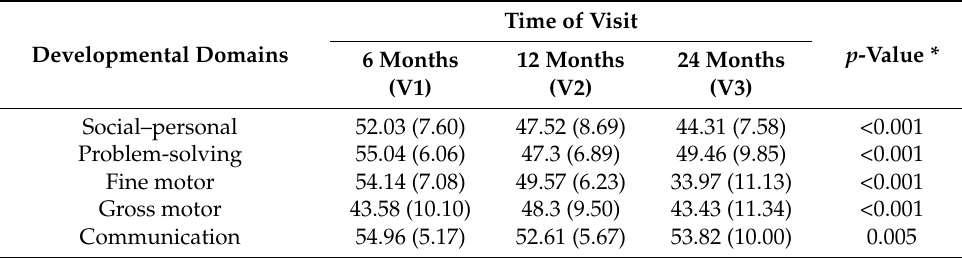
Table 3. Mean ASQ-3 scores for each developmental domain at three different times of visit.